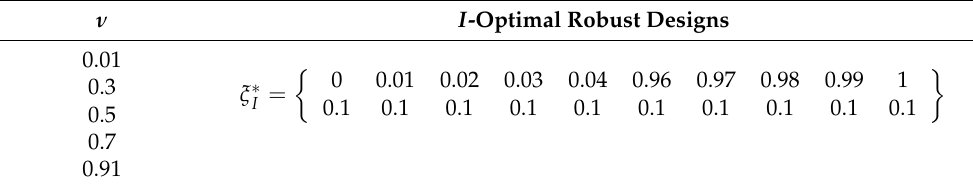
Table 4. 10-point I -optimal robust designs computed for the log-logistic